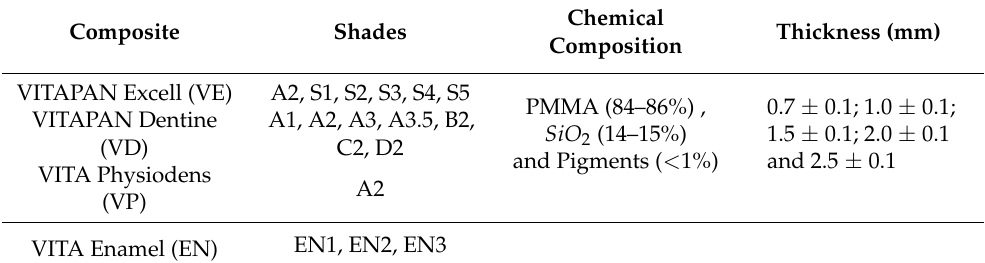
Table 1. Specifications of the dental resin-based composites used in this